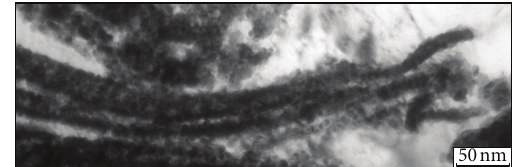
Figure 6: Banded clusters of tantalum in